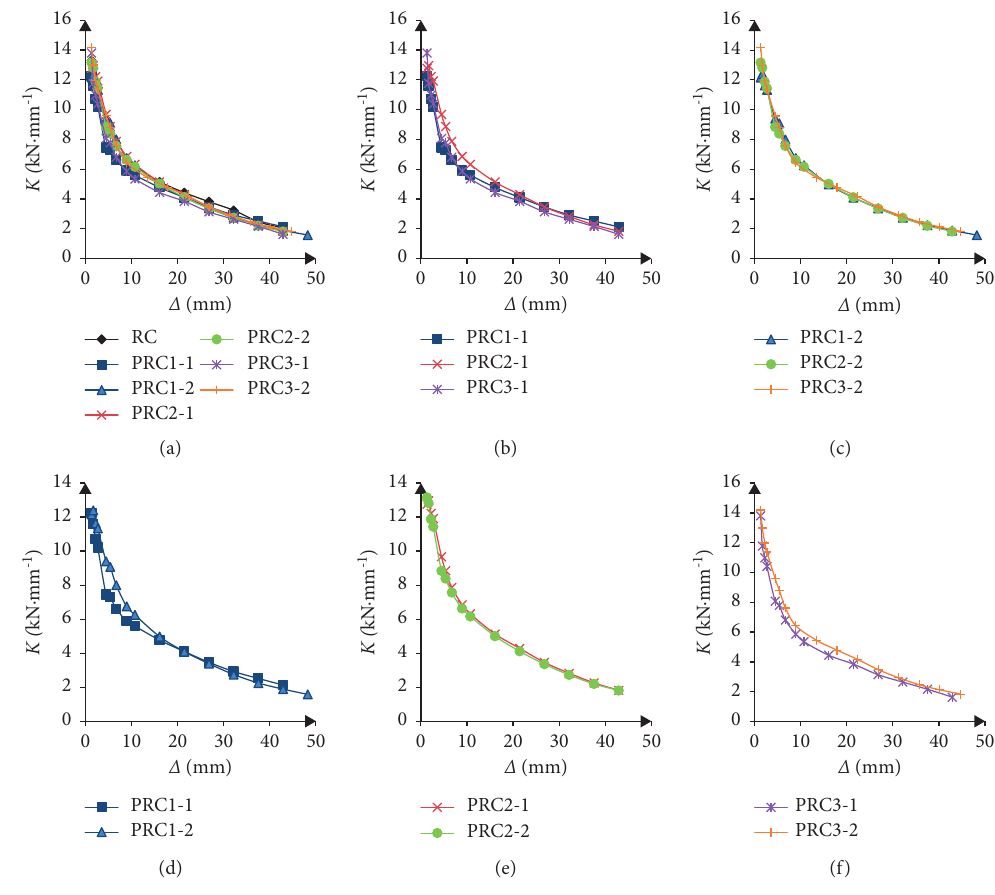
Figure 10: Secant stiffness-displacement curves ( K - Δ ) of specimens. Table 4: Secant stiffness K (kN/mm) and secant stiffness degradation coefficient c (%) of specimens. Specimen